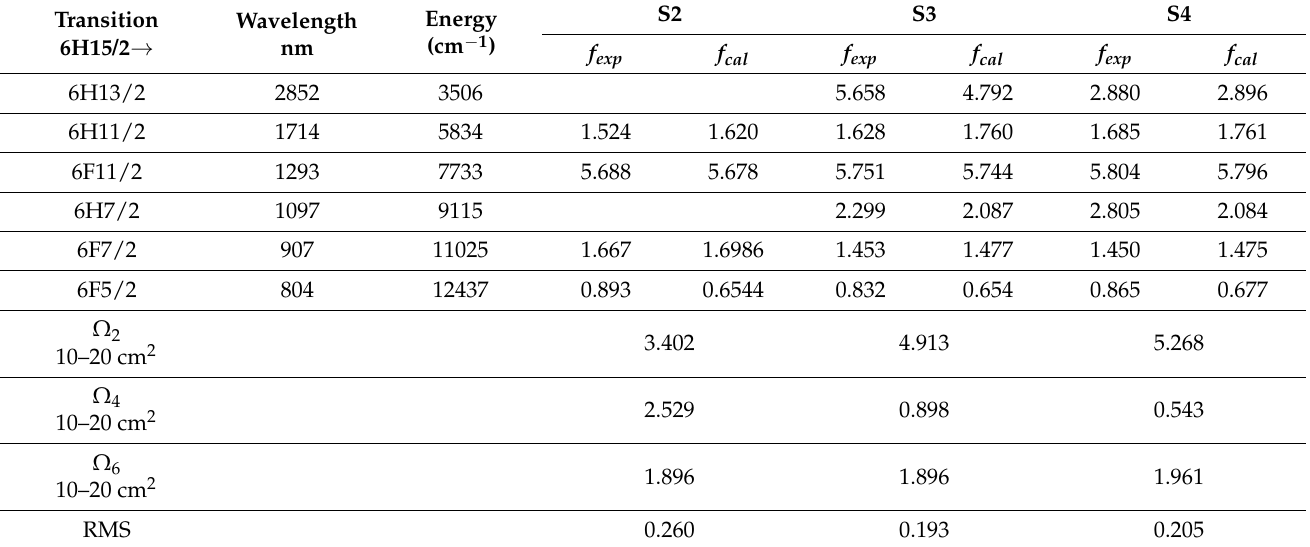
Table 3. Experimental ( f exp ) and calculated ( f cal ) oscillator strengths along (from the ground state, 6H15/2), with JO parameters of prepared glass